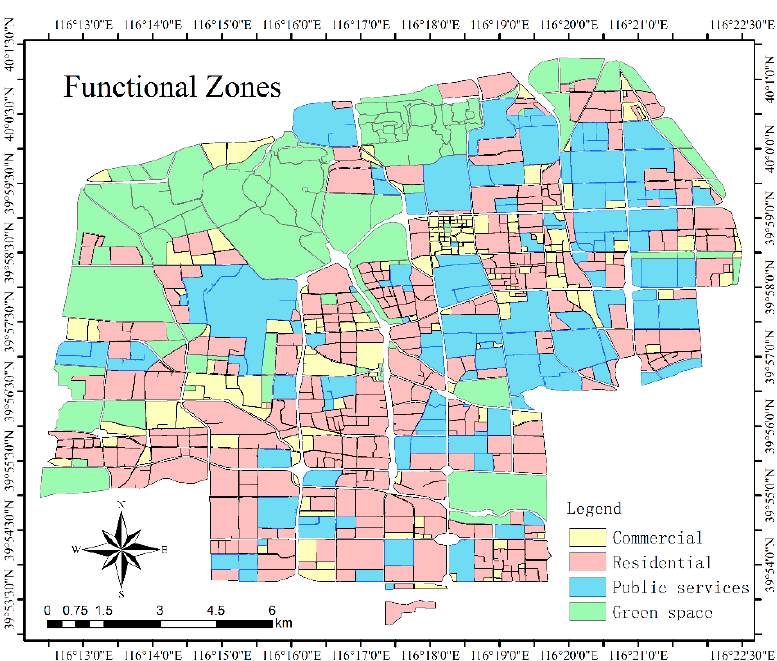
Figure 7. Functional zone identification